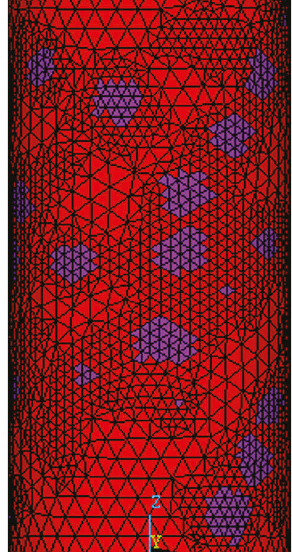
Figure 3: Contact element of model.